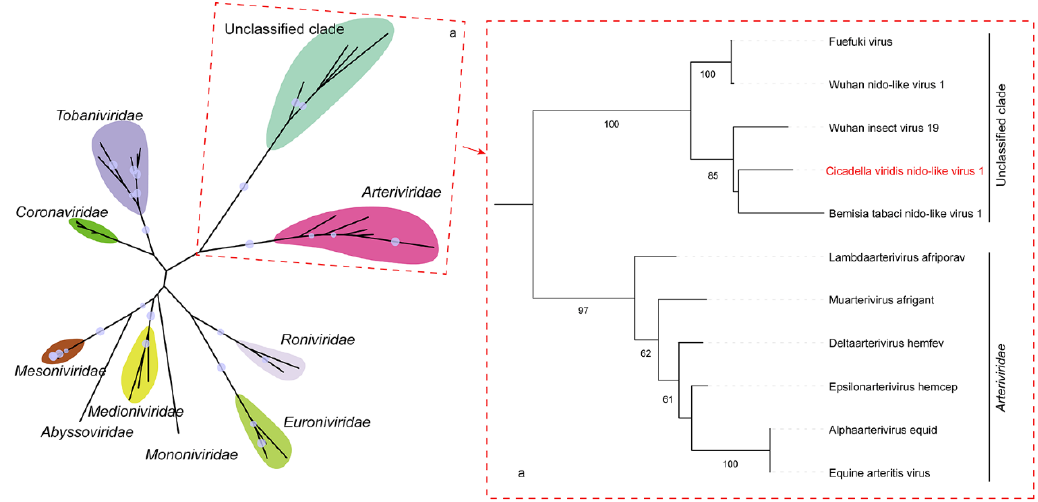
Figure 3. Phylogenetic analysis of Cicadella viridis nido-like virus 1 (CvNiLV1) with other nidoviruses. Maximum likelihood phylogenetic tree based on the RNA-dependent RNA polymerase was constructed with a bootstrap of 1000. A taxonomic overview of viruses at order Nidovirales are shown on the left, and a close-up view of two interested clades are shown in the dotted frames on the right.